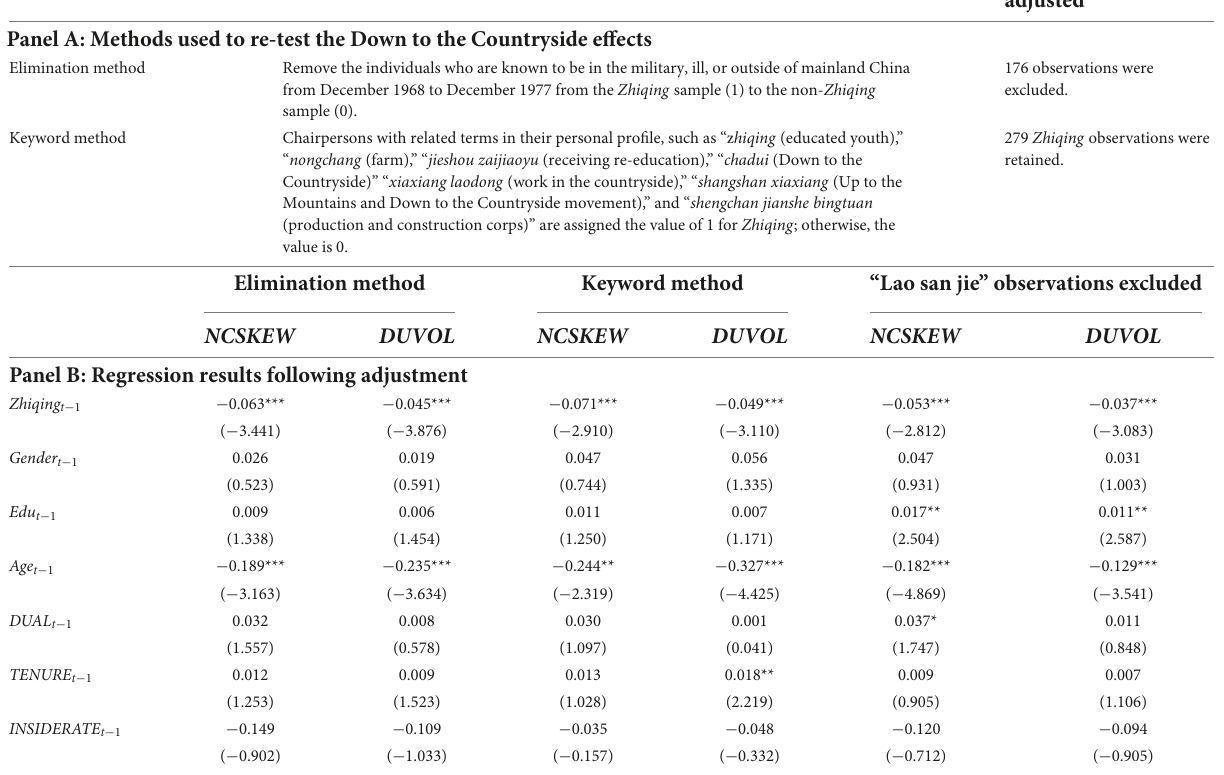
TABLE 10 Robustness check methods and